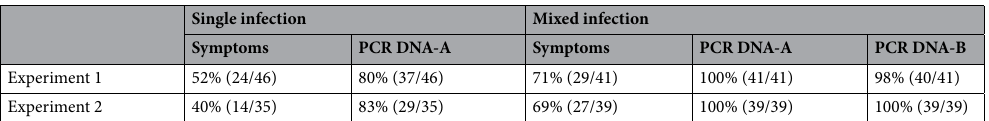
Table 3. Transmission rates of PepYVMLV in single or mixed infection with DNA-B by synchronous females of Bemisia tabaci MEAM1.